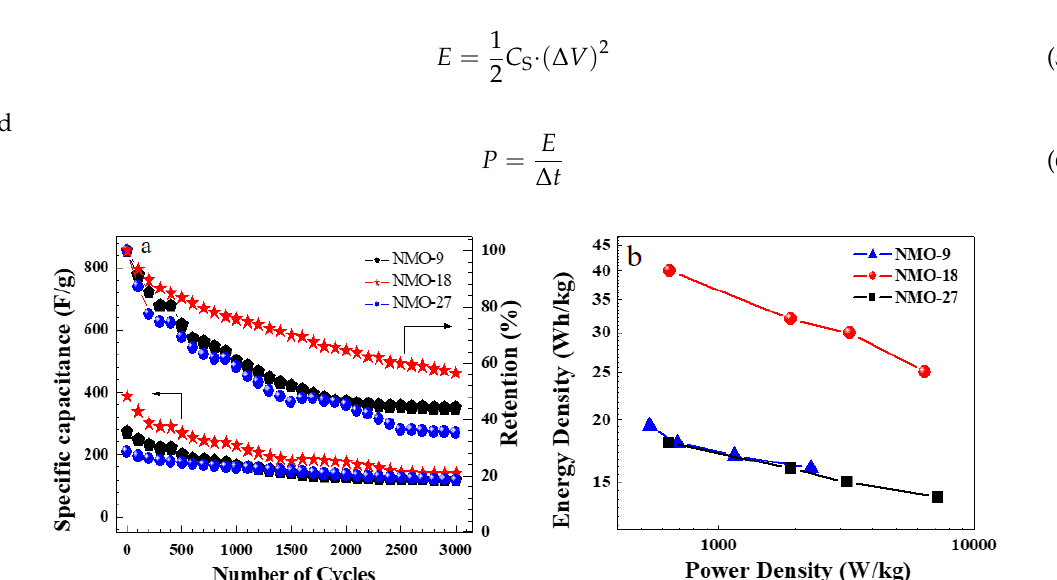
Figure 7. ( a ) Response of specific capacitance over 3000 cycles of charge-discharge operations for NMO-9, NMO-18, and NMO-27; ( b ) Ragone plots with energy density versus power density.